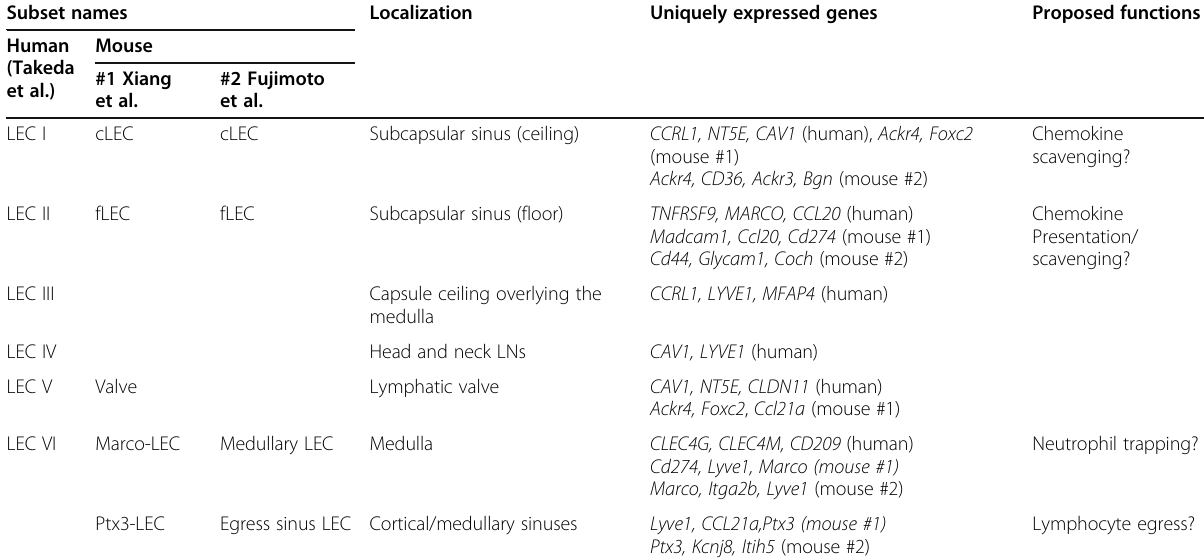
Table 1 LEC subsets in human and mouse LNs Subset names Localization Uniquely expressed genes Proposed